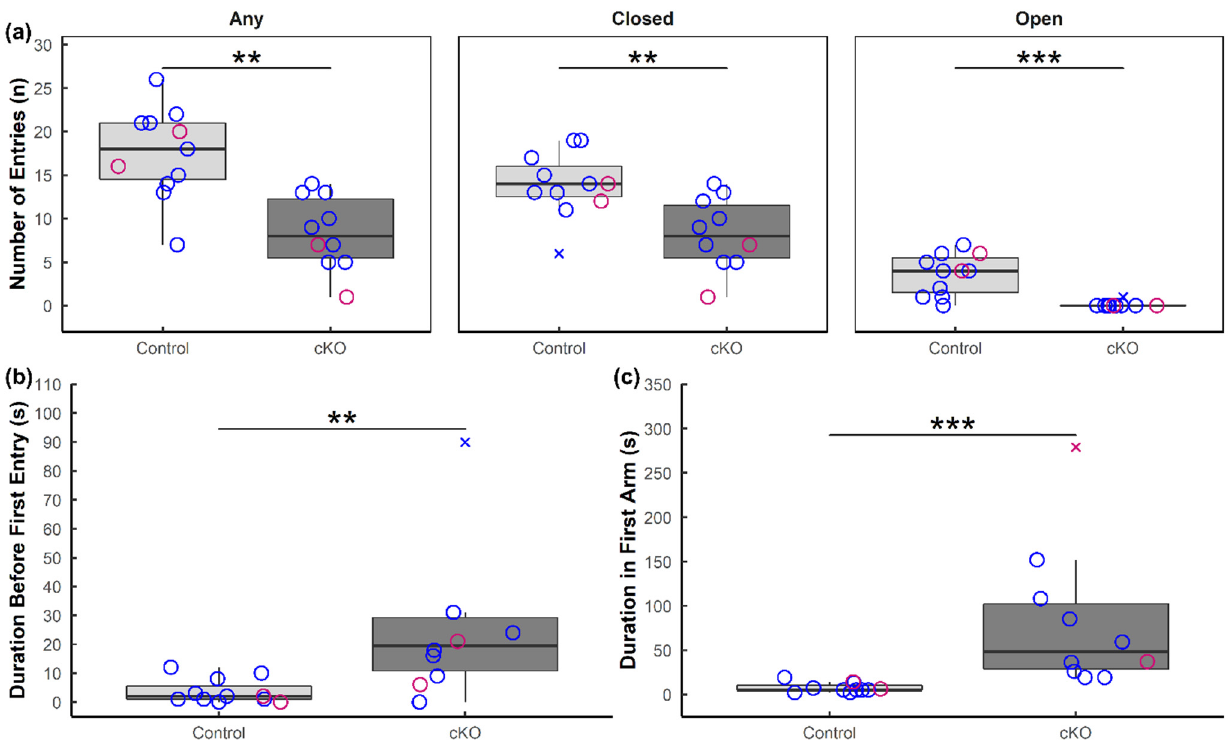
Figure 3. Anxiety-like behavior in Sox2 cKO mice observed during the elevated plus maze. ( a ) Number of entries of Sox2 cKO mice ( n = 10) and littermate controls ( n = 11) into any arm of the EPM, only closed arms, and only open arms. ( b ) Amount of time before the subject first left the neutral middle and entered any arm of the EPM. ( c ) Duration of time the subject spent in the first arm of the EPM. Female mice are denoted in pink and male mice are denoted in blue. Outliers are denoted by cross marks. Statistical significance from Wilcoxon rank-sum tests is marked with ** ( p < 0.01) or *** ( p <